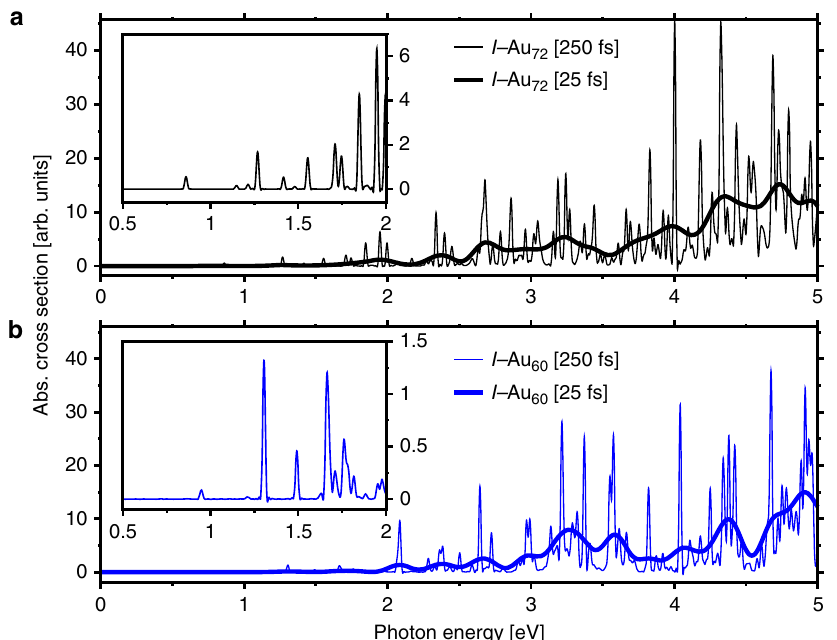
Fig. 6 Optical absorption spectra of the chiral-icosahedral shells. The optical absorption spectra are computed from the time evolution of the electron density, over periods of 25 fs (low resolution, bold lines) and 250fs (high resolution, fi ne lines) for a the I − Au 60 and b the I − Au 72 . The insets expand the low-energy (0.5 – 2.0 eV) range, in order to highlight the distinct patterns of the I − Au 60 vs. I − Au 72